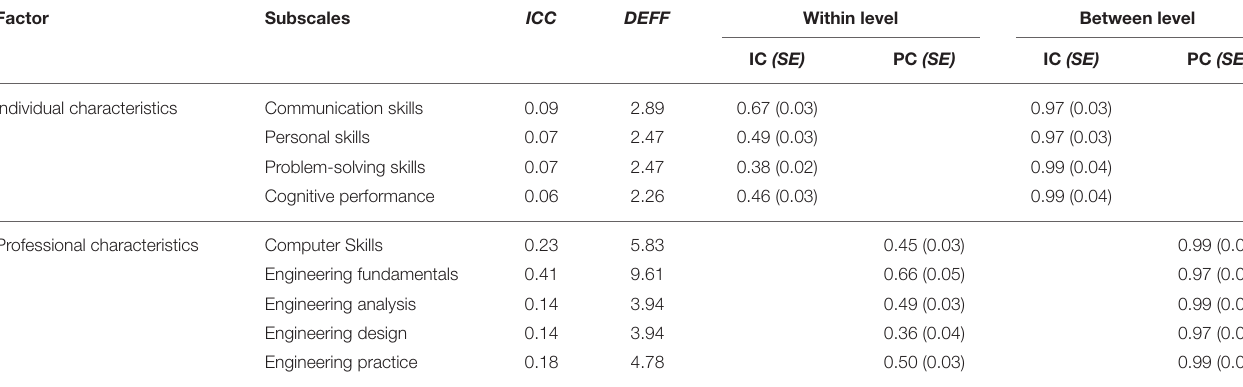
TABLE 2 | Completely standardized factor loadings, intraclass correlation coefficients and design effect indices ( N = 1,696). Factor